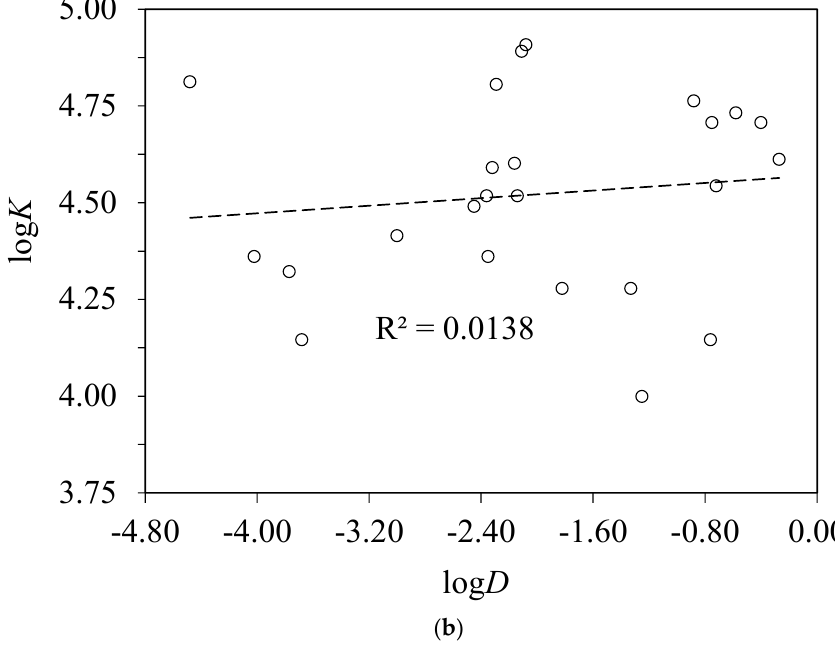
Figure 5. Plots of the logarithms of binding constants log K of substituted benzoic acids to BSA against their octanol–water partition coefficients log P [34] ( a ) and log D ( b ).